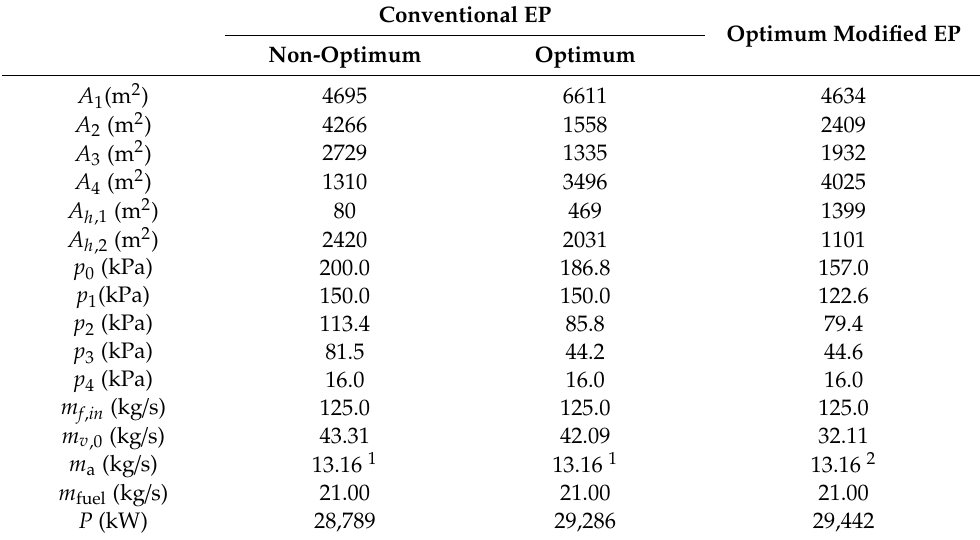
Table 1. Simulation results of cogeneration systems for the non ‐ optimum conventional evaporation process, the optimum conventional evaporation process, and the optimum modified evaporation process .